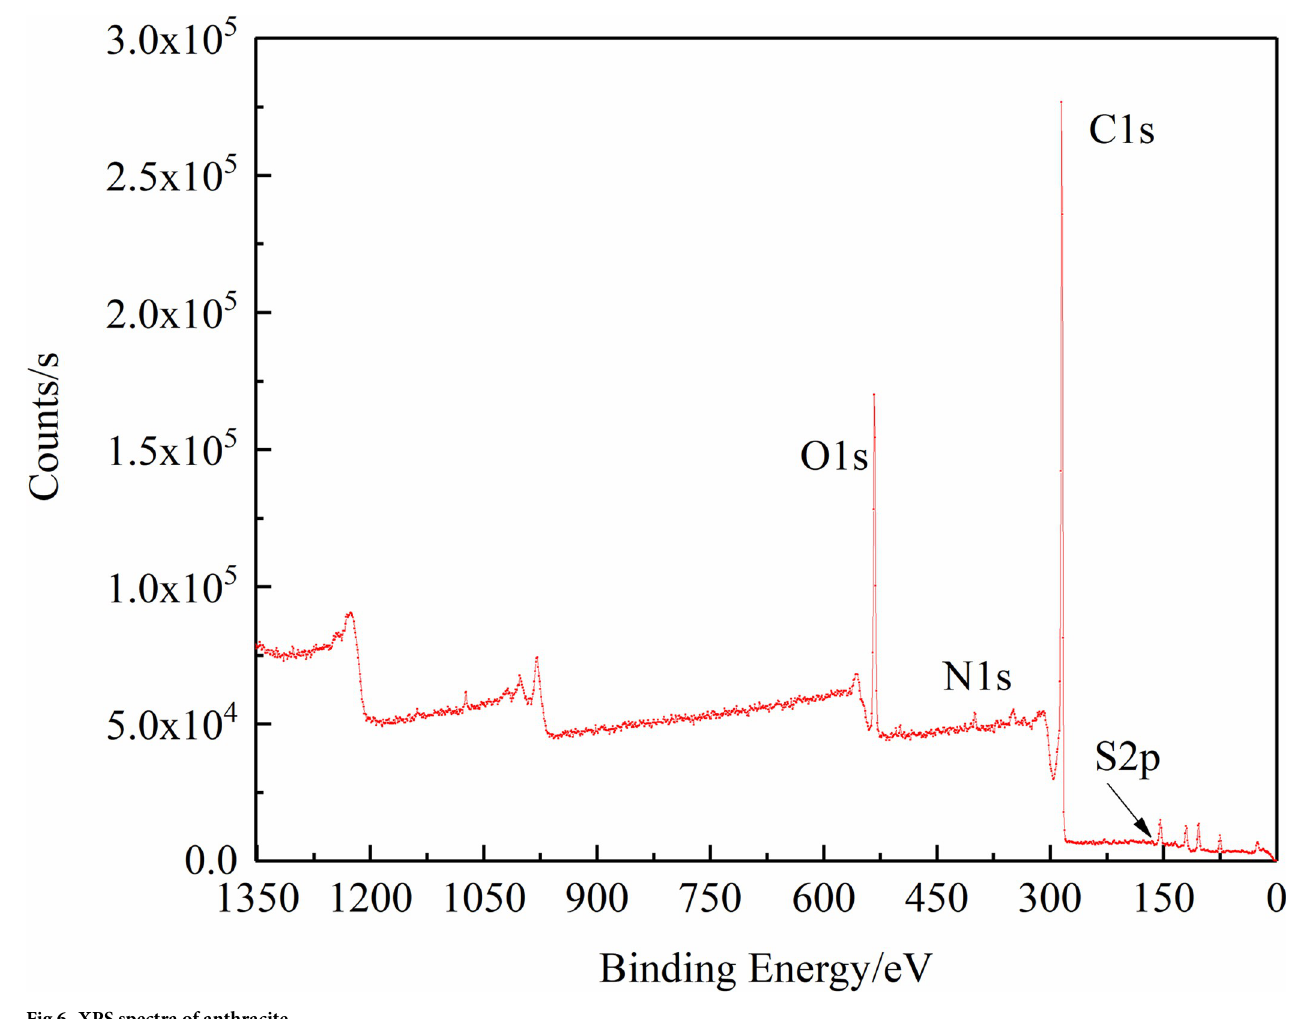
Fig 6. XPS spectra of anthracite.